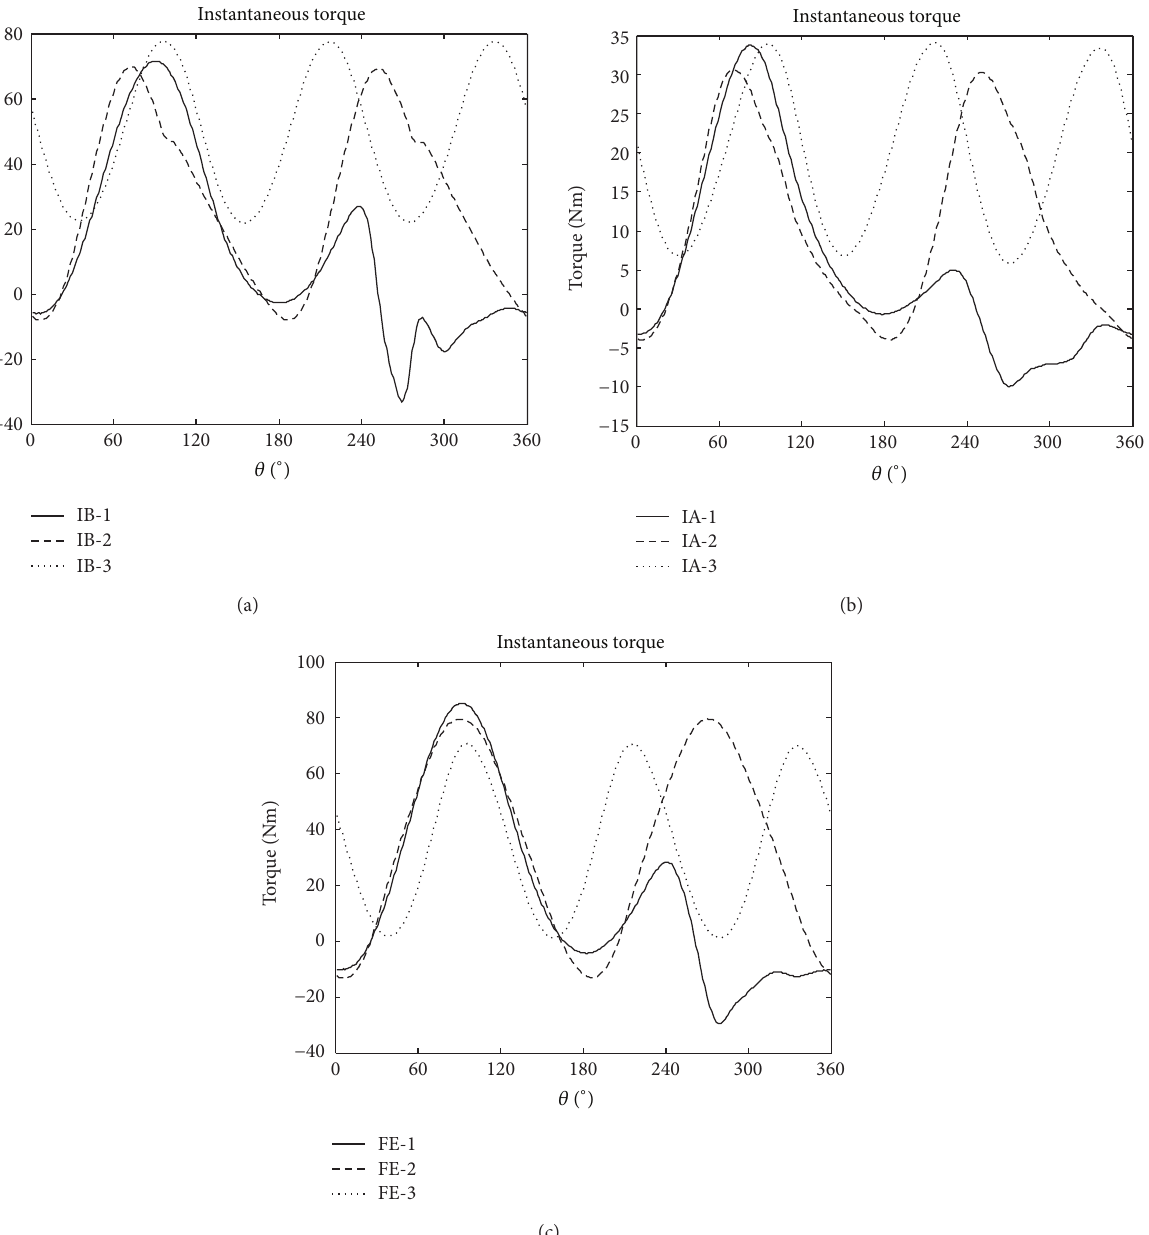
Figure 11: (a) Instantaneous total torque when a different number of isolated blades are present in the simulation. (b) Instantaneous total torque when a different number of isolated set of arms are present in the simulation. (c) Instantaneous total torque when a different number of full elements are present in the